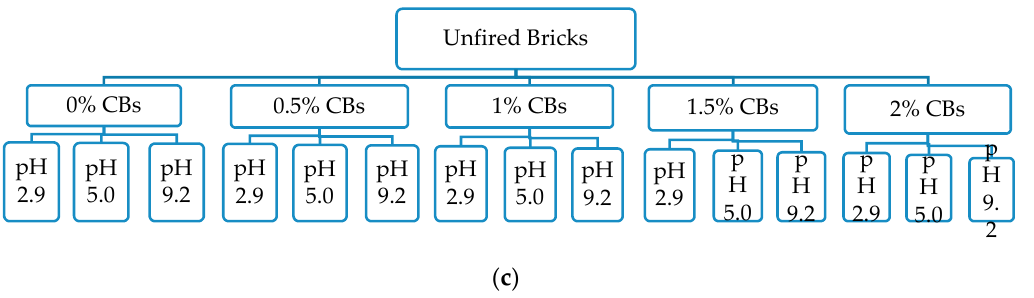
Figure 2. Leaching procedure for leachates derived from ( a ) used, unused, and shredded used CBs and ( b ) fired clay bricks and ( c ) unfired clay bricks incorporating 0%, 0.5%, 1%, 1.5%, and 2% CBs by mass.